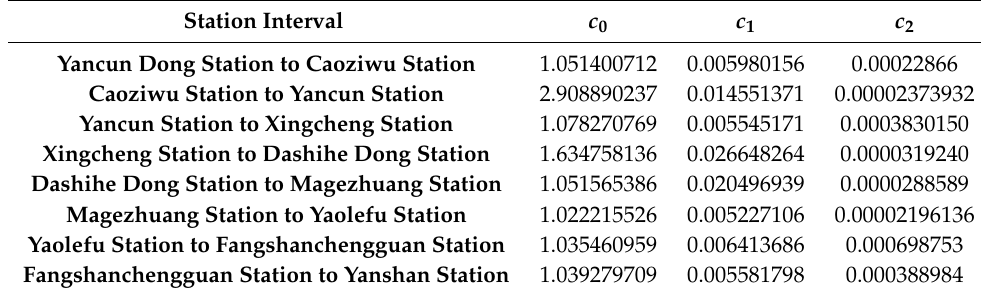
Table 6. Parameter settings of PTDM-II.